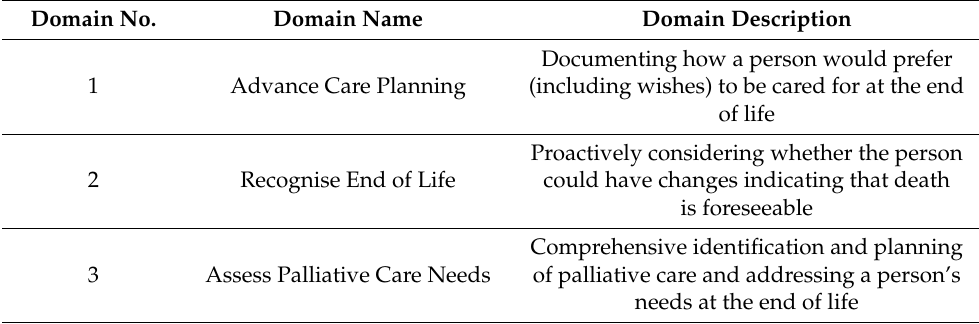
Table 1. The eight domains of the End of Life Directions for Aged Care (ELDAC) care model [19]. Domain